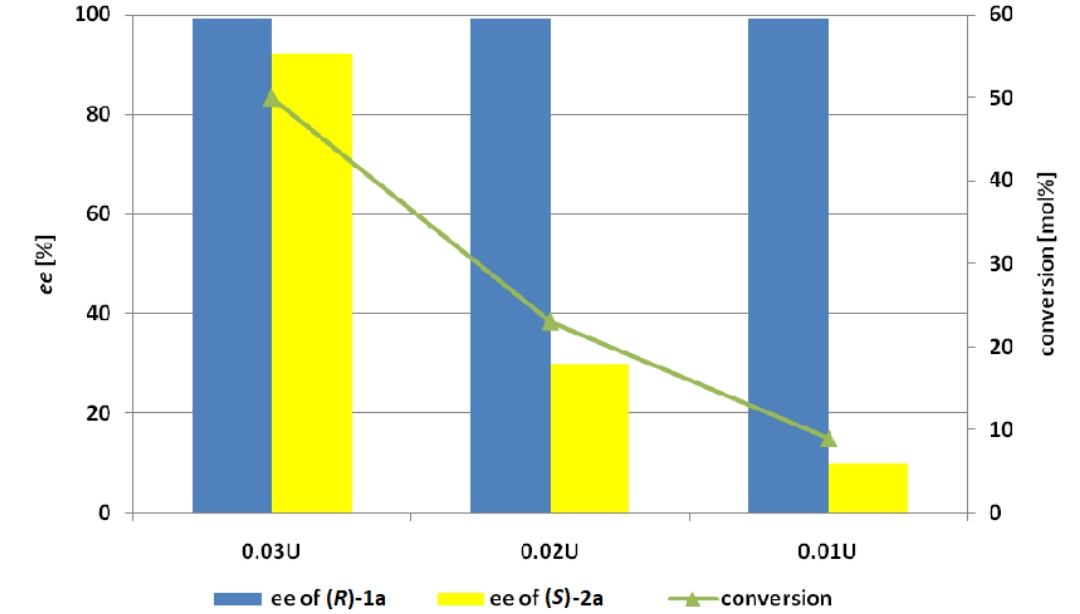
Figure 4. The e ff ect of the dose of Lecitase Ultra immobilized on cyanogen bromide-activated agarose (LU-CNBr) on the conversion and enantiopurity of the products after 24 h of hydrolysis of racemic acetate 2a in phosphate bu ff er (pH 7.2) and acetone as the